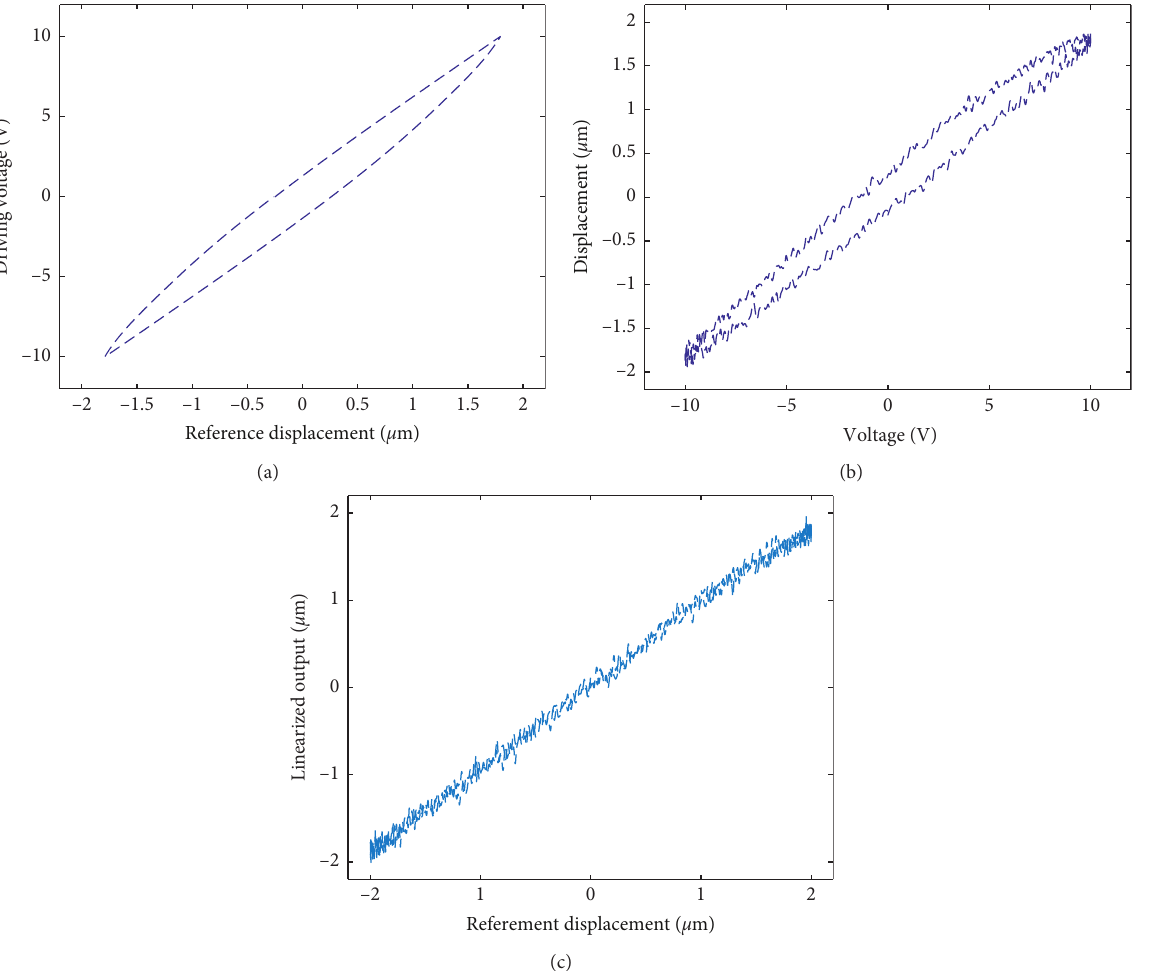
Figure 13: The feedforward compensation results in the Y -direction. (a) The hysteresis inverse model in the Y -direction. (b) The output hysteresis curve. (c) The linearized